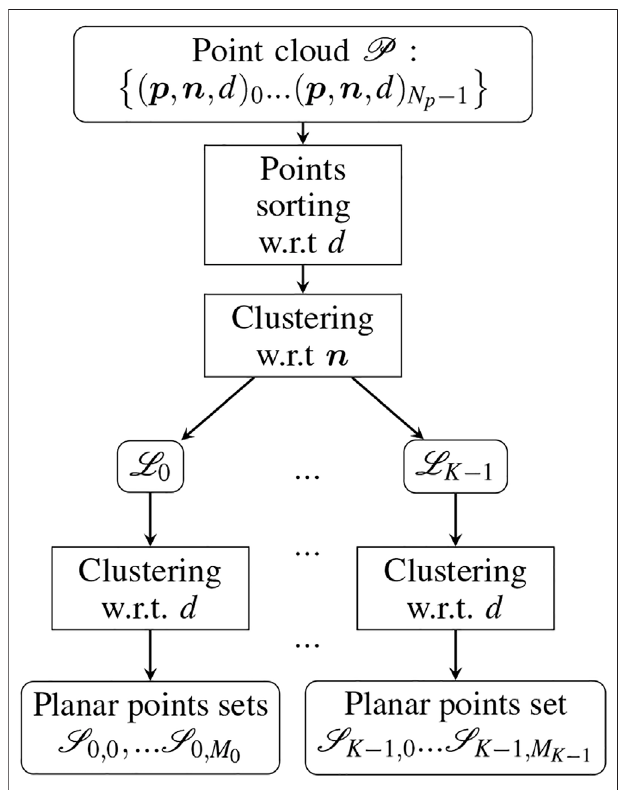
FIGURE1| Overviewoftheplanarsegmentationalgorithm.Itconsistsof two clustering phases: the fi rst one is for the normals ’ space, and the second one separates parallel